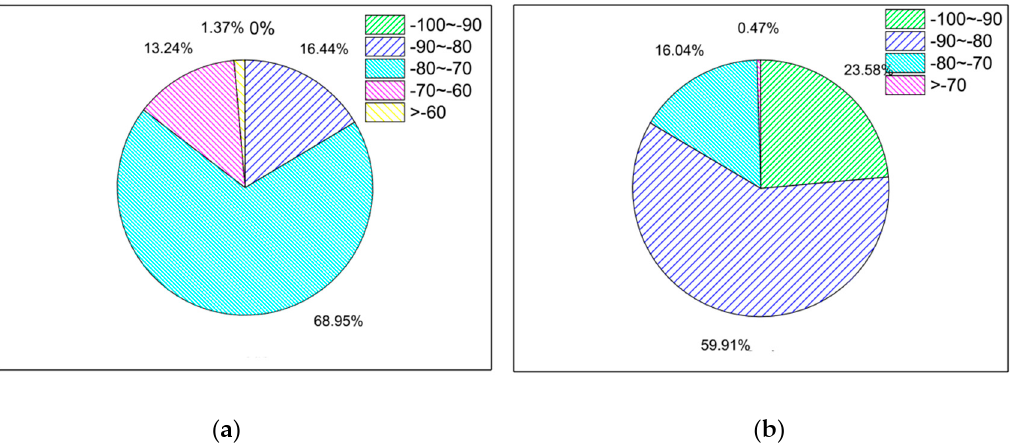
Figure 5. The pie distribution diagram of the average signal strength of the passengers during the fine grain time. ( a ) In the bus. ( b ) Out of the bus.